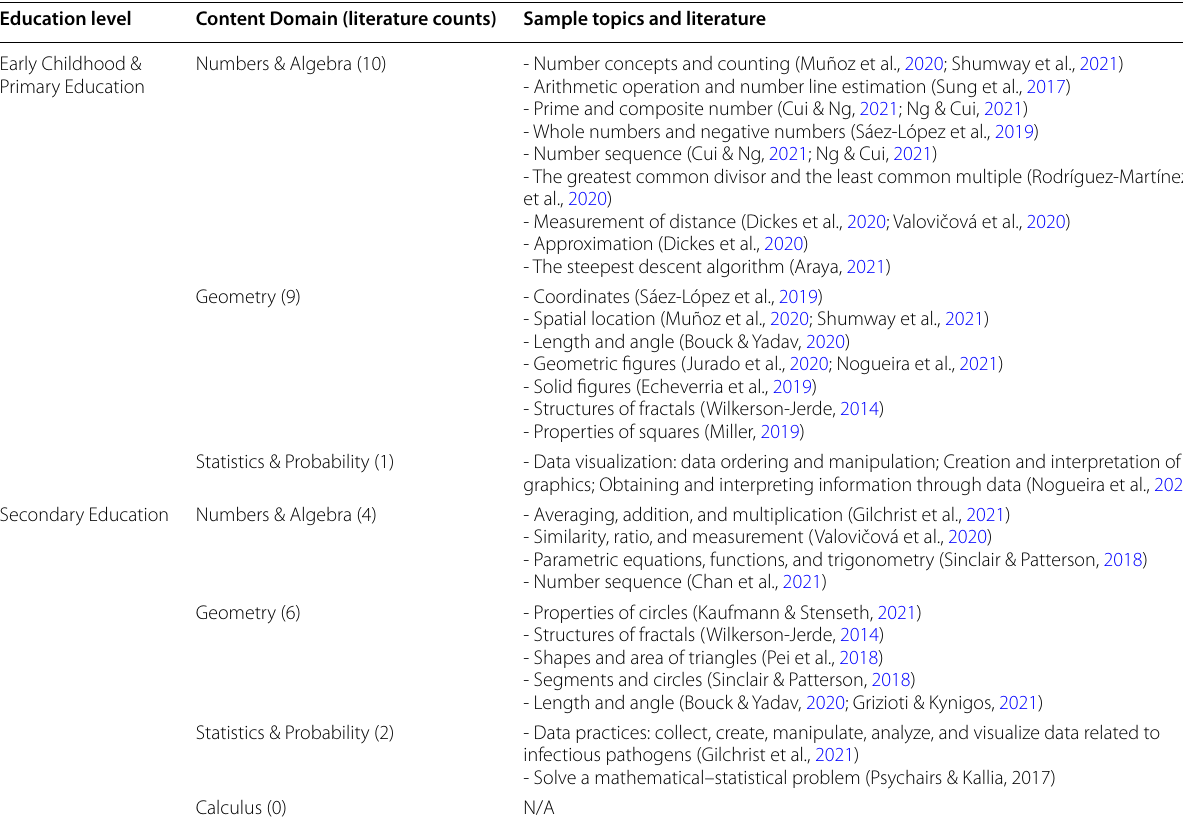
Table 5 Literature counts of each mathematical domain at different education